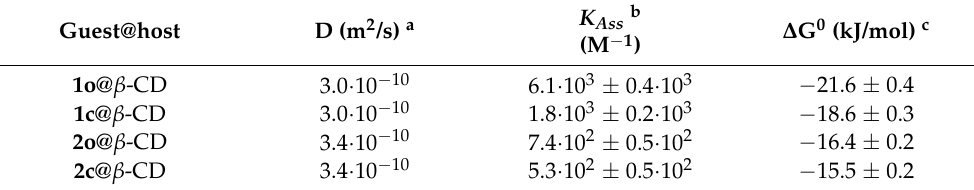
∆ G 0 = − RTln K Ass ) and Equation: Ass